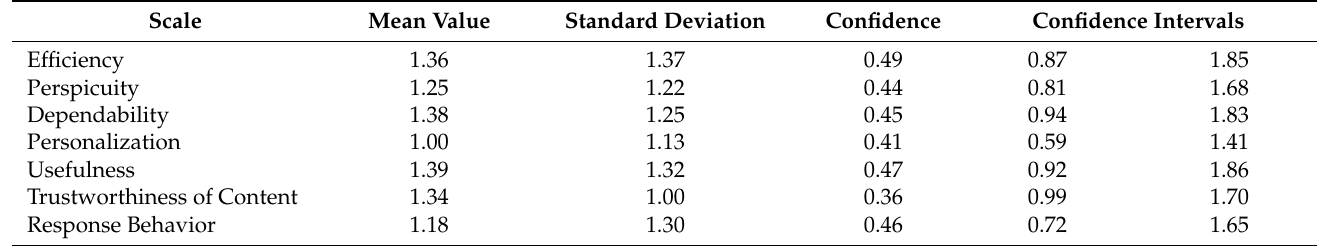
Table 5. Mean value, standard deviation and confidence intervals of the selected